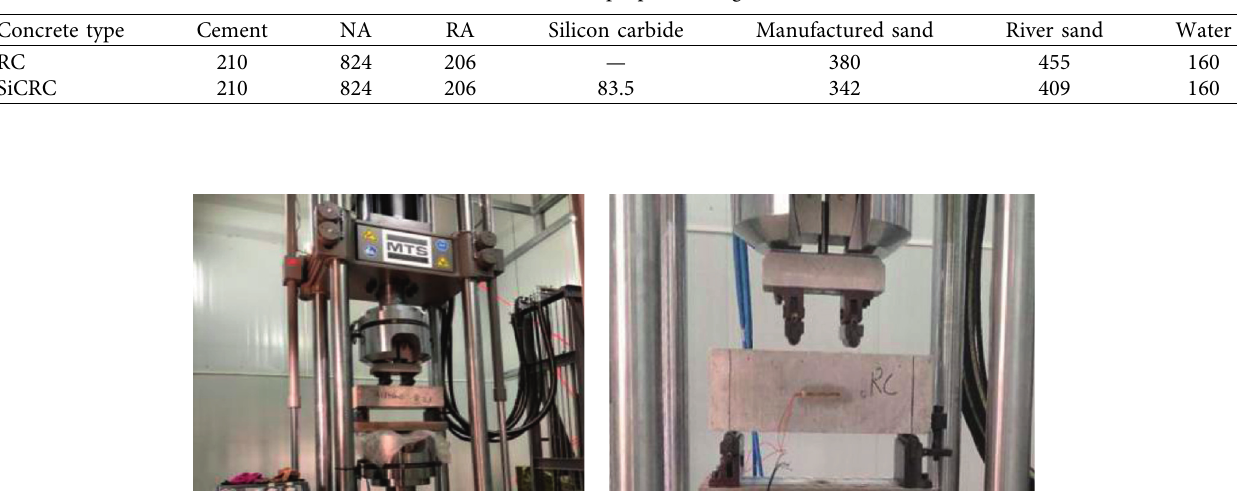
Table 2: Mixture proportion (kg/m 3 ).